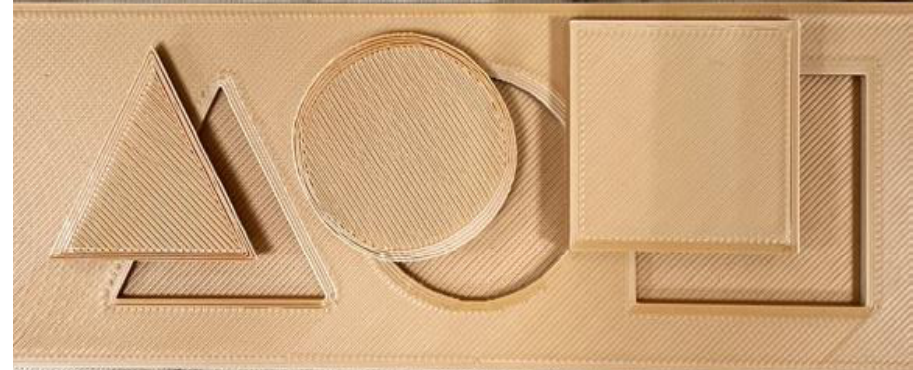
Figure 7. Sample of the generated and 3D printed tactile peg puzzle.